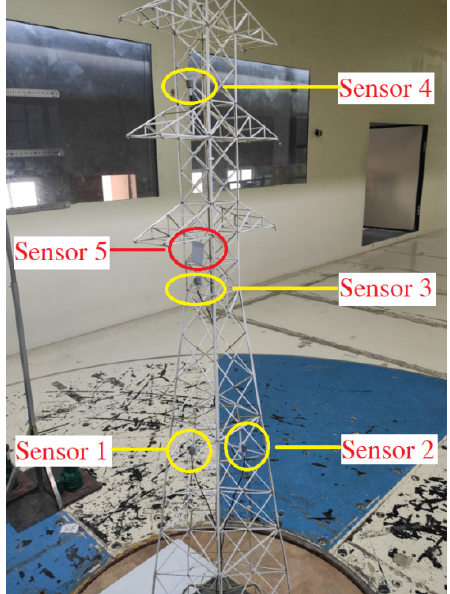
Figure 14. The meshing grilles.